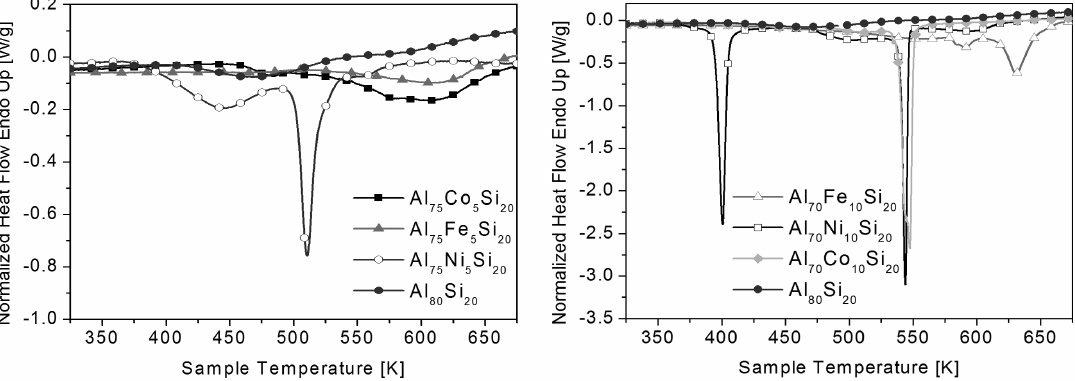
Figure 3. DSC measurement (linear heating